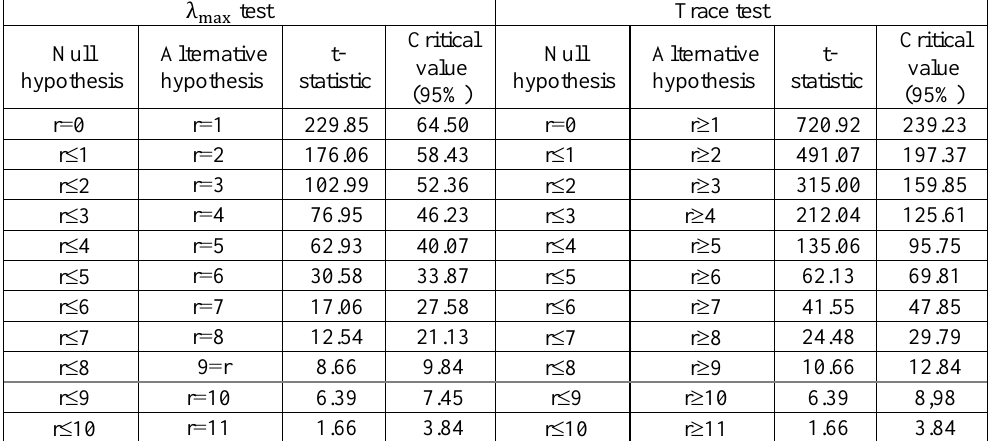
Table 4. Results of Johansson cointegration